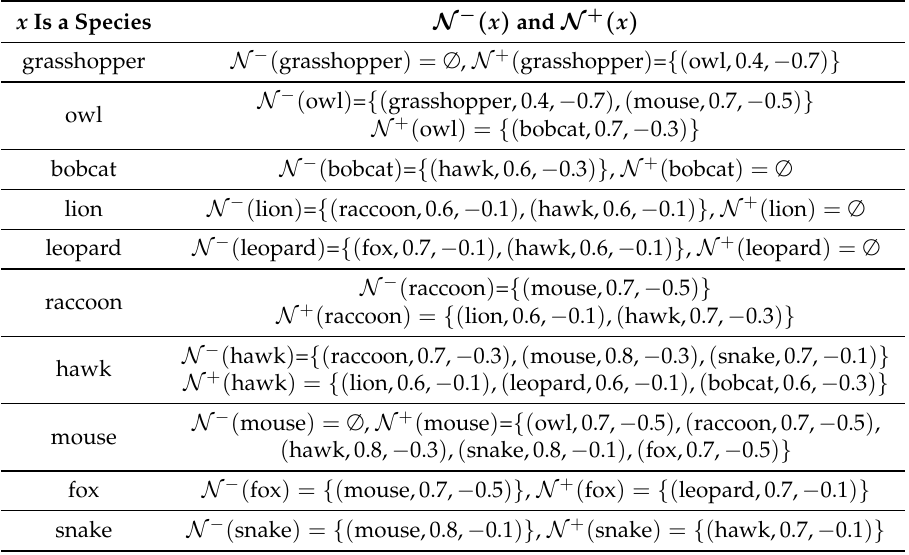
Table 7. Bipolar fuzzy out neighborhoods and in